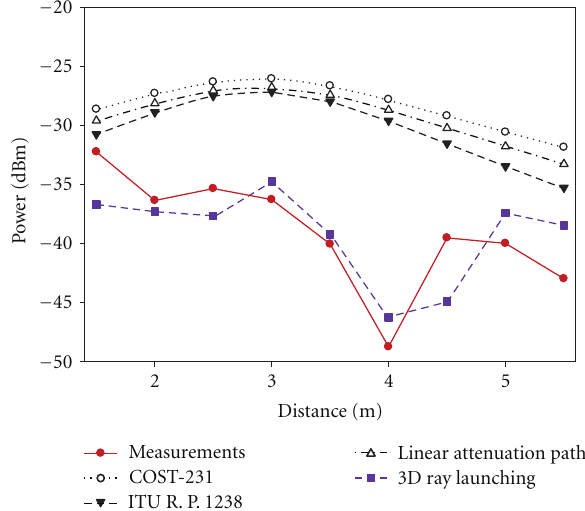
Figure 9: Comparison Measurements versus di ff erent Propagation Models for X = 0 . 5 m along the Y